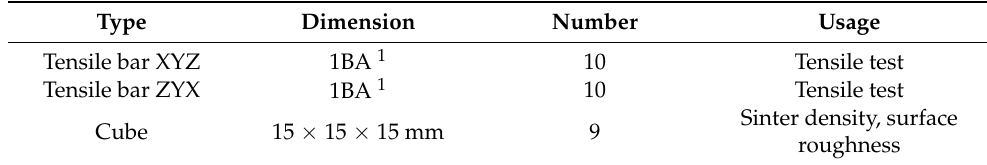
Table 1. Breakdown of the used specimens in the designed build job.